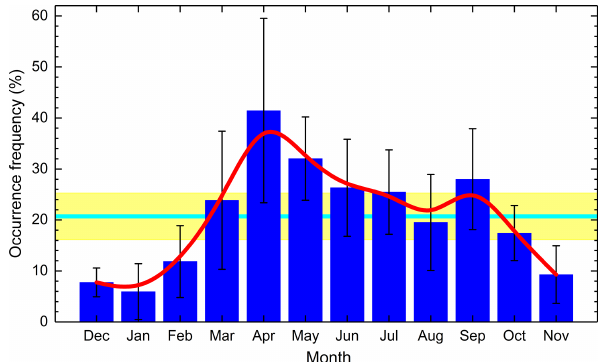
Figure 3. Mean distribution of the monthly mean relative occur- rence frequency of NPF event days for the joint 6-year-long data set in the city centre. The error bars show ± 1SD, the horizontal line in cyan indicates the overall mean and the yellow band represents its ± 1SD. The smooth curve in red serves to guide the